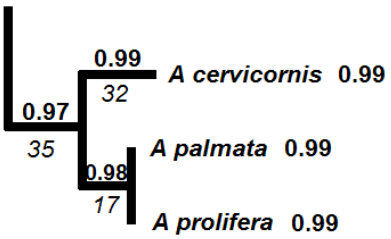
Figure 3. Subset of the larger tree (Figure 2) showing the three Acropora species found in the Caribbean. Relevant branch lengths are shown below branch, in italics. Bold numbers indicate probabilities of extinction, with probability for a deeper branch equal to product of probabilities of